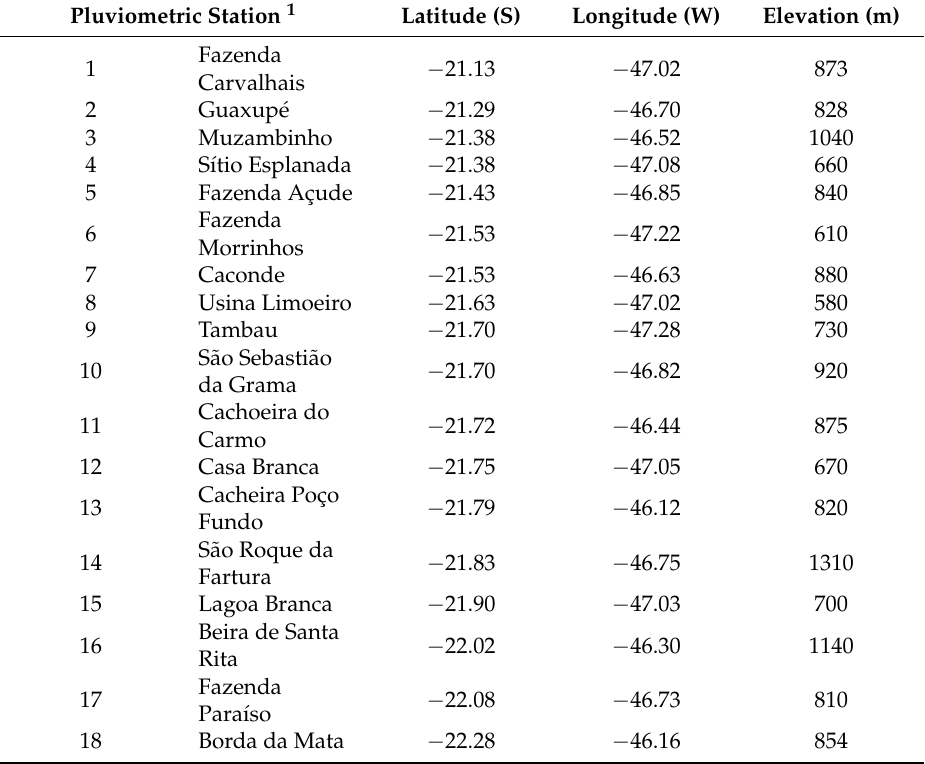
Table 1. List of the 18 pluviometric stations used in the spatial interpolation.